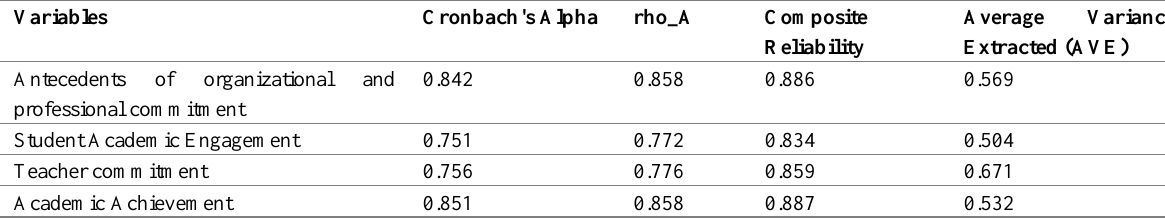
Table 5: Validity of the measurement